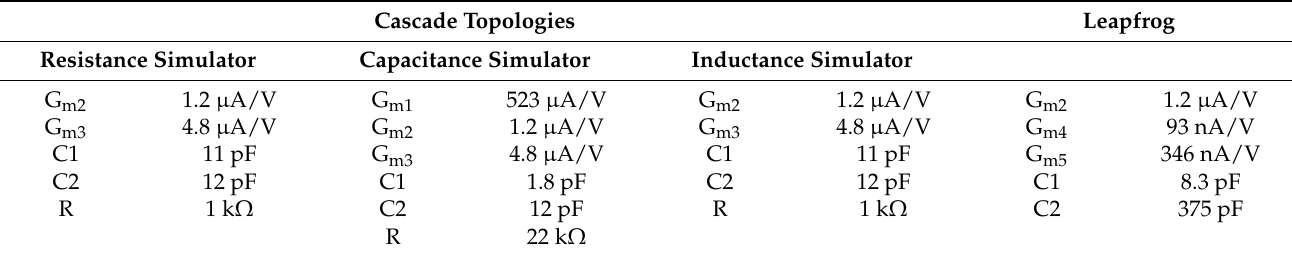
Table 3. Parameter values of each filter implementation.